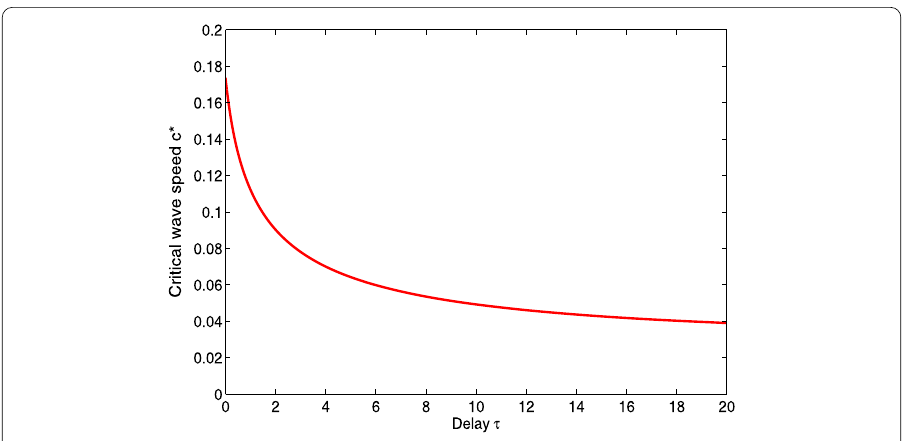
Figure 5 The relationship between time delay τ and the critical wave speed c